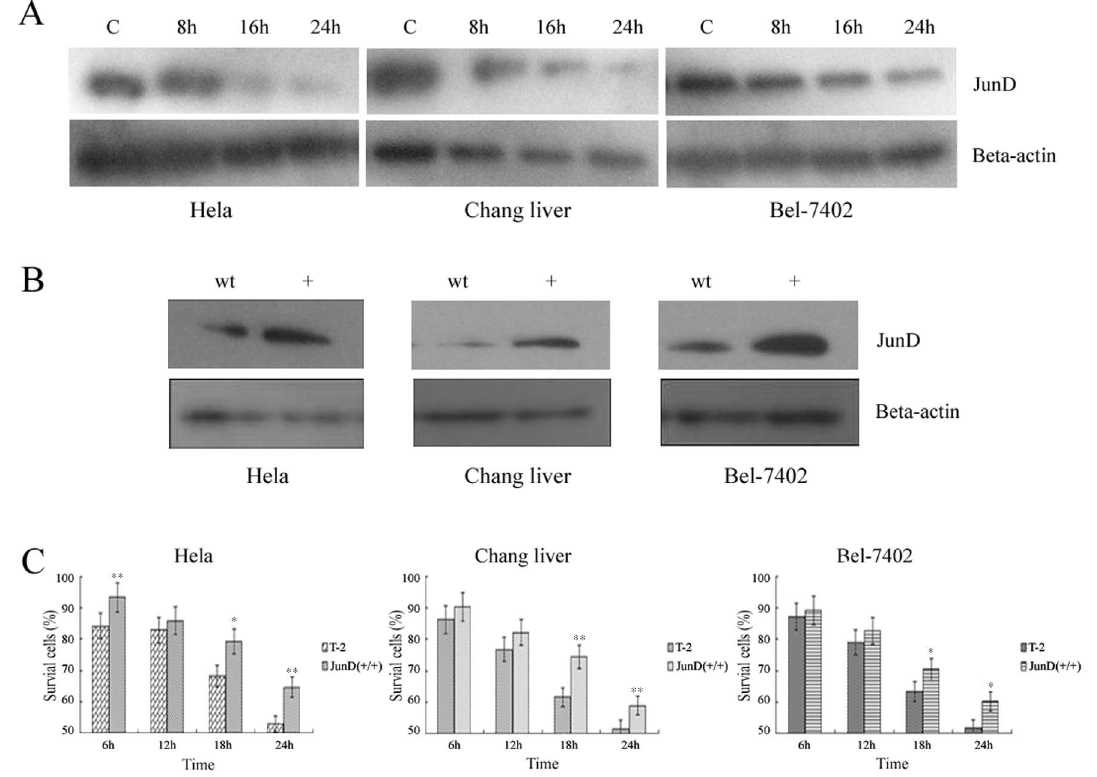
Figure 7. The effect of up-regulated JunD on cells. A . The expression levels of JunD induced by T-2 toxin. B . The expression of JunD after transfection of JunD over-expression vector in three cell strains. wt: wild type. + : cell strains transfected with over-expression vector. C . The effect of over-expressed JunD on cell survival rate. T-2: wild-type cells under T-2 toxin stress. JunD ( + / + ): JunD over-expressied cell lines under T-2 toxin stress. Data was presented as mean 6 SD. *p , 0.05, **p , 0.01, ***p ,